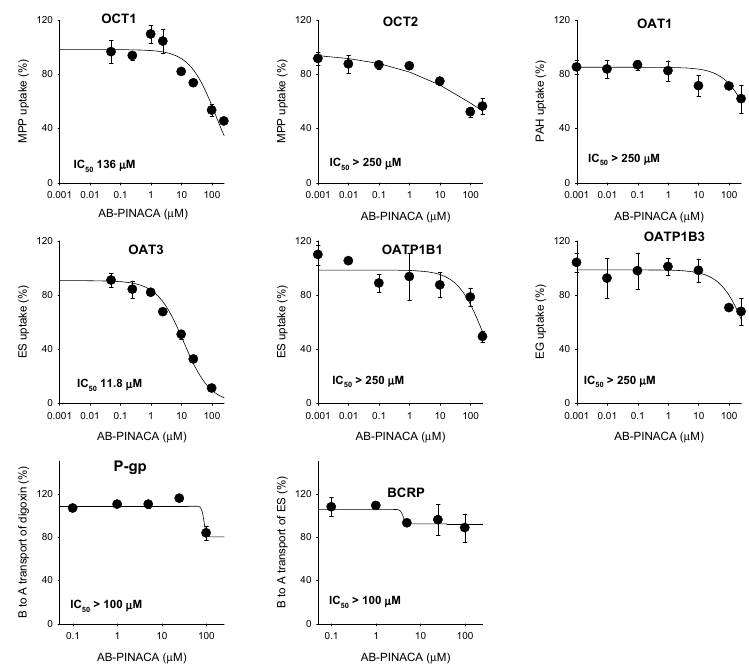
Figure 5. Inhibitory effects of AB-PINACA (0.1–250 µM) on OCT1- and OCT2-mediated 3 H-methyl-4-phenylpyridinium (MPP + ) (0.1 µM) uptake, OAT1-mediated 3 H-para-aminohippuric acid (PAH) (0.1 µM) uptake, OAT3- and OATP1B1-mediated [ 3 H]estrone-3-sulfate (ES) (0.1 µM) uptake, OATP1B3-mediated 3 H-estradiol-17 β - D -glucuronide (EG) (0.1 µM) uptake in HEK293 cells overexpressing OCT1, OCT2, OAT1, OAT3, OATP1B1, and OATP1B3. Inhibitory effect of AB-PINACA (0.1–100 µM) on P-gp-mediated B to A transport of 3 H-digoxin (0.1 µM), and BCRP-mediated B to A transport of 3 H-ES (0.1 µM) in LLC-PK1-MDR1 and LLC-PK1-BCRP cells. The data are means ± SD ( n = 3).